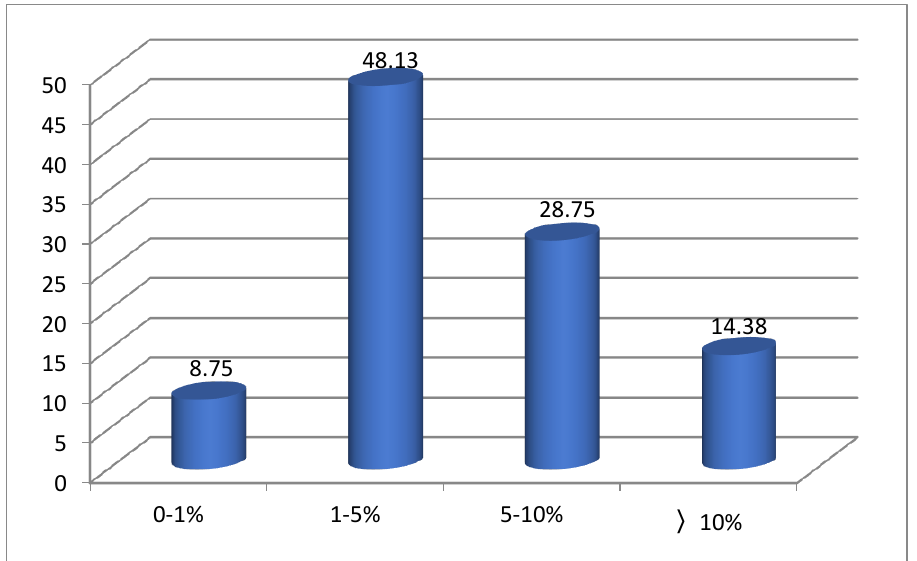
Figure 3. Percent of logEC 50 (AChE) values in different absolute relative deviation (ARD%) ranges of the MLR model.